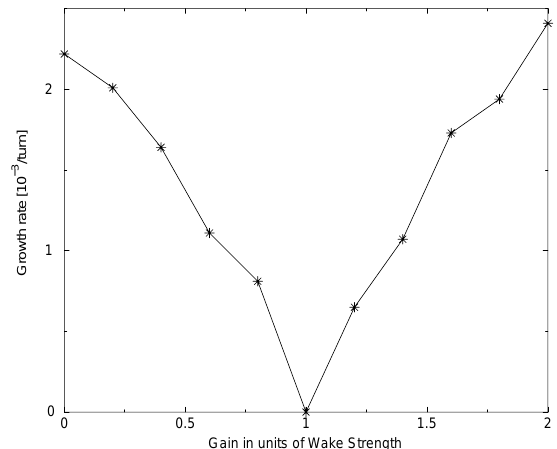
FIG. 3. Growth rate of the bunching factor as a function of the gain of the feedback system. The filter coefficients are identical to the wake function ( Q (cid:1) 1 resonator at first harmonic plus space charge). Note the perfect cancellation when the gain is identical to the strength of the